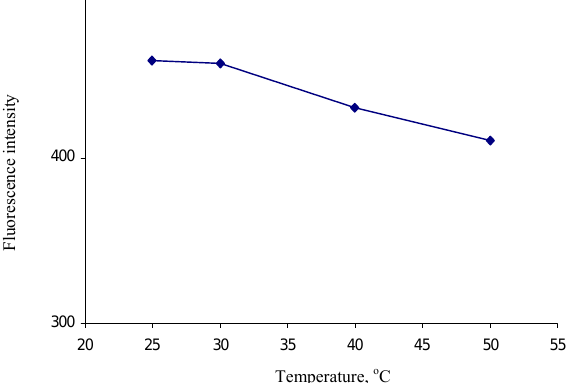
Figure 2. Effect of temperature on fluorescence